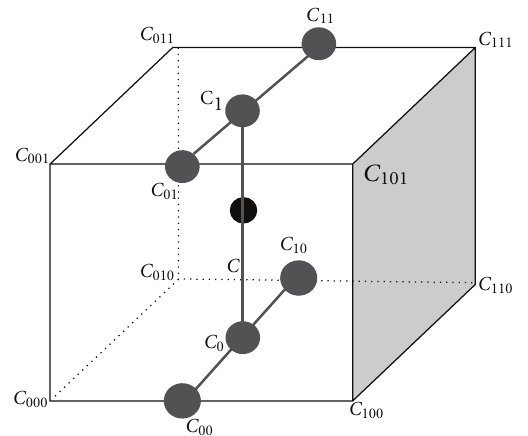
Figure 2: 3D trilinear